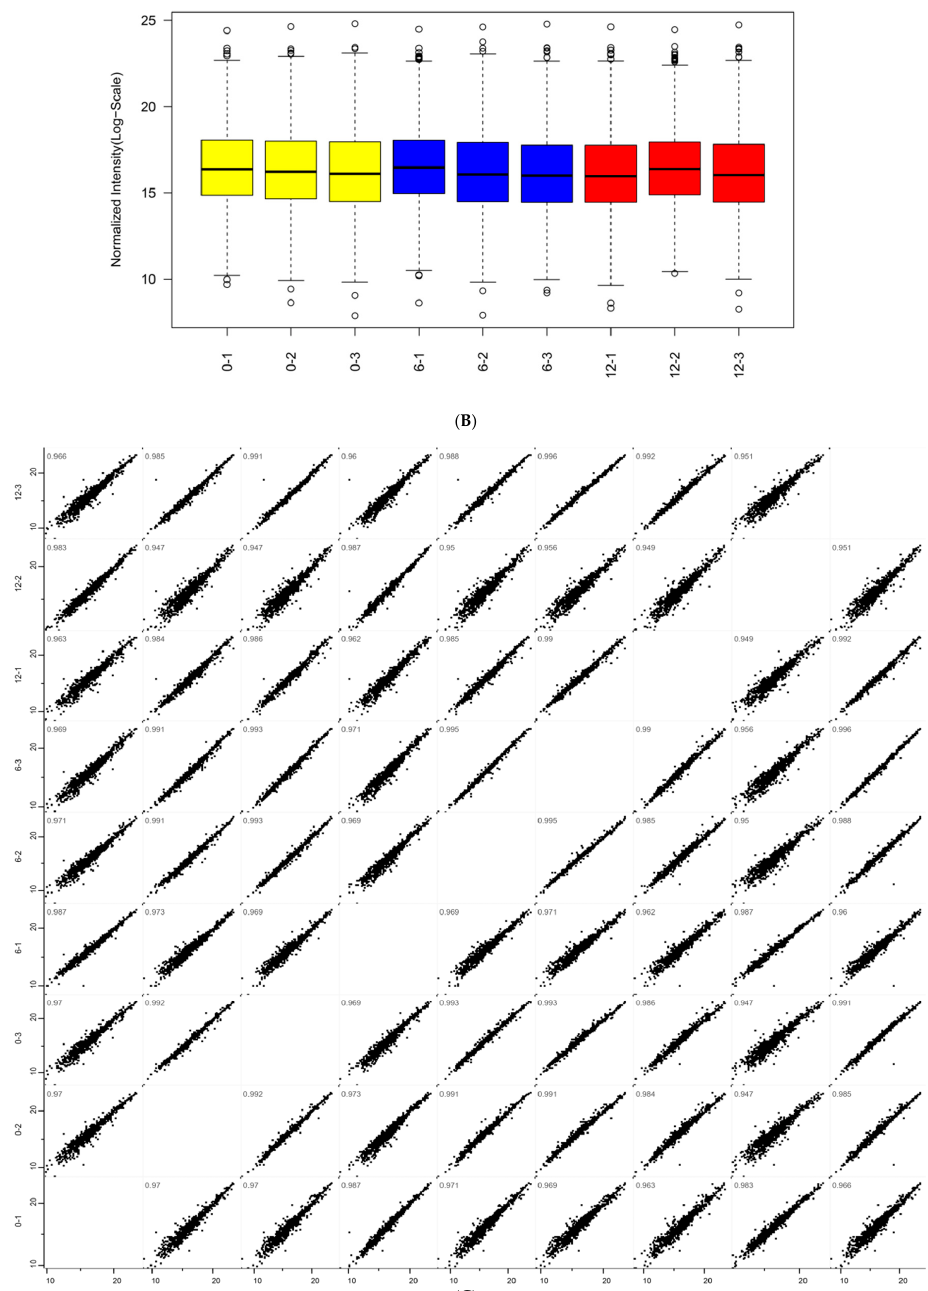
Figure 2. ( A ) Histogram of log2 protein intensity for each Sample; ( B ) box plots of log2 protein (or Reporter ion) intensity average for each sample; and ( C ) a matrix of scatter plots and Pearson correlation coefficient of Protein intensities for each sample.